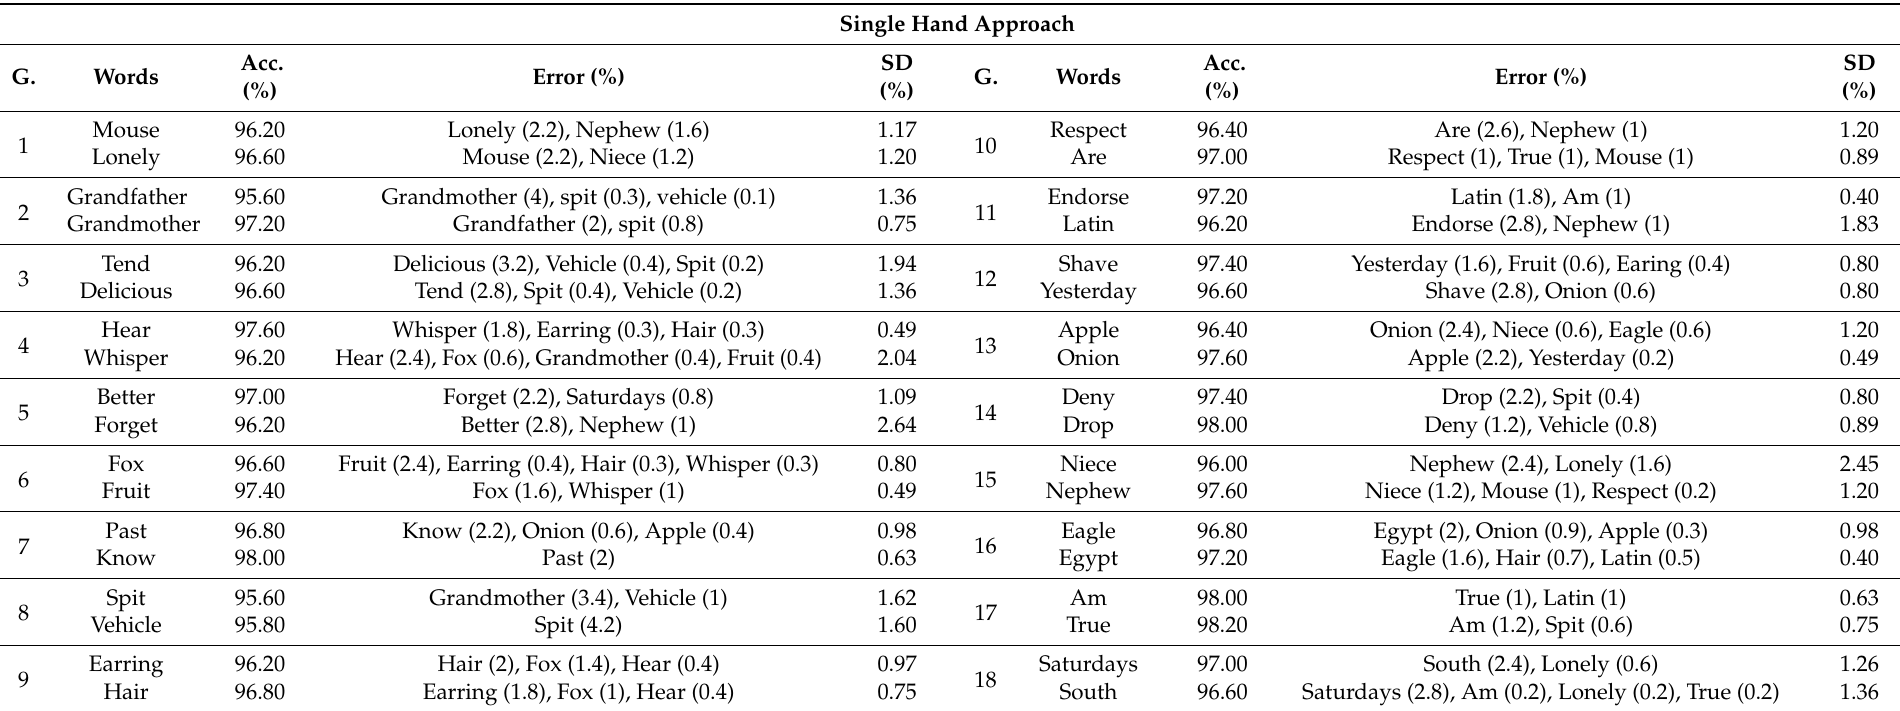
Table 10. Signed-word recognition based on single-hand data based on a backhand view and using 5-fold cross validation. Single Hand Approach